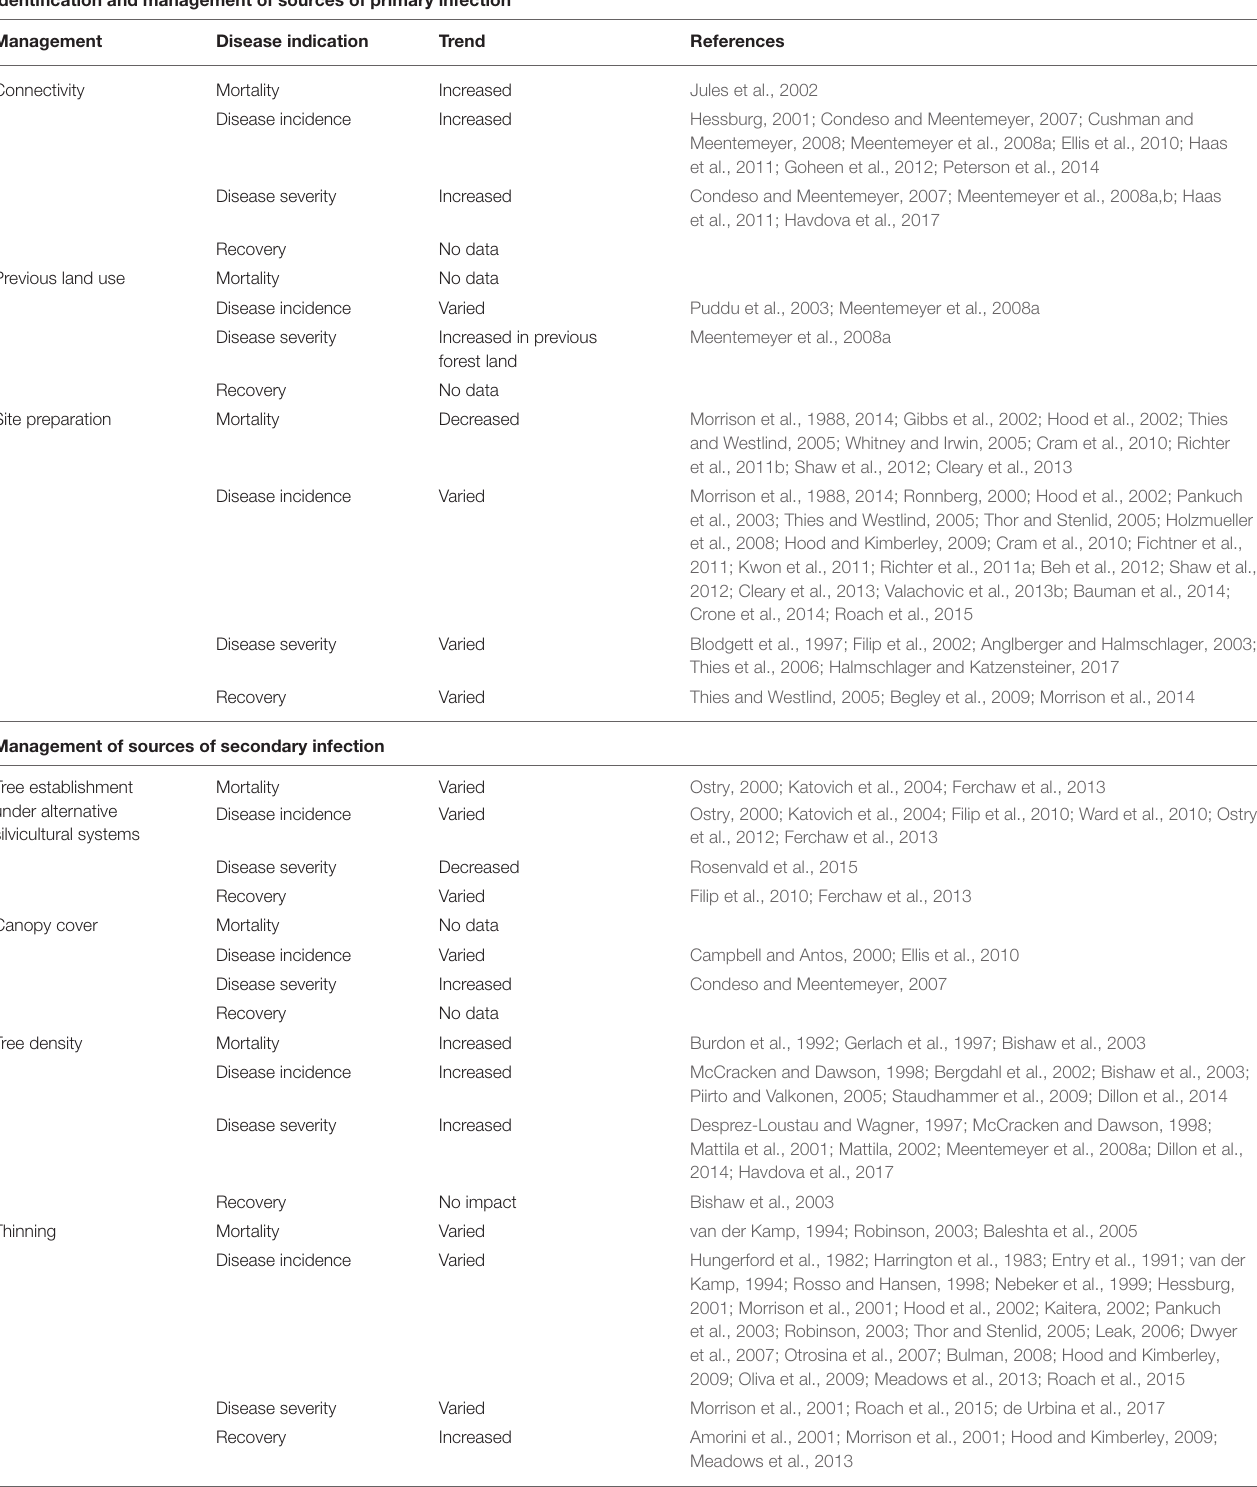
TABLE 2 | Overview of published evidence of effects of forest management on resilience to tree diseases. Identification and management of sources of primary